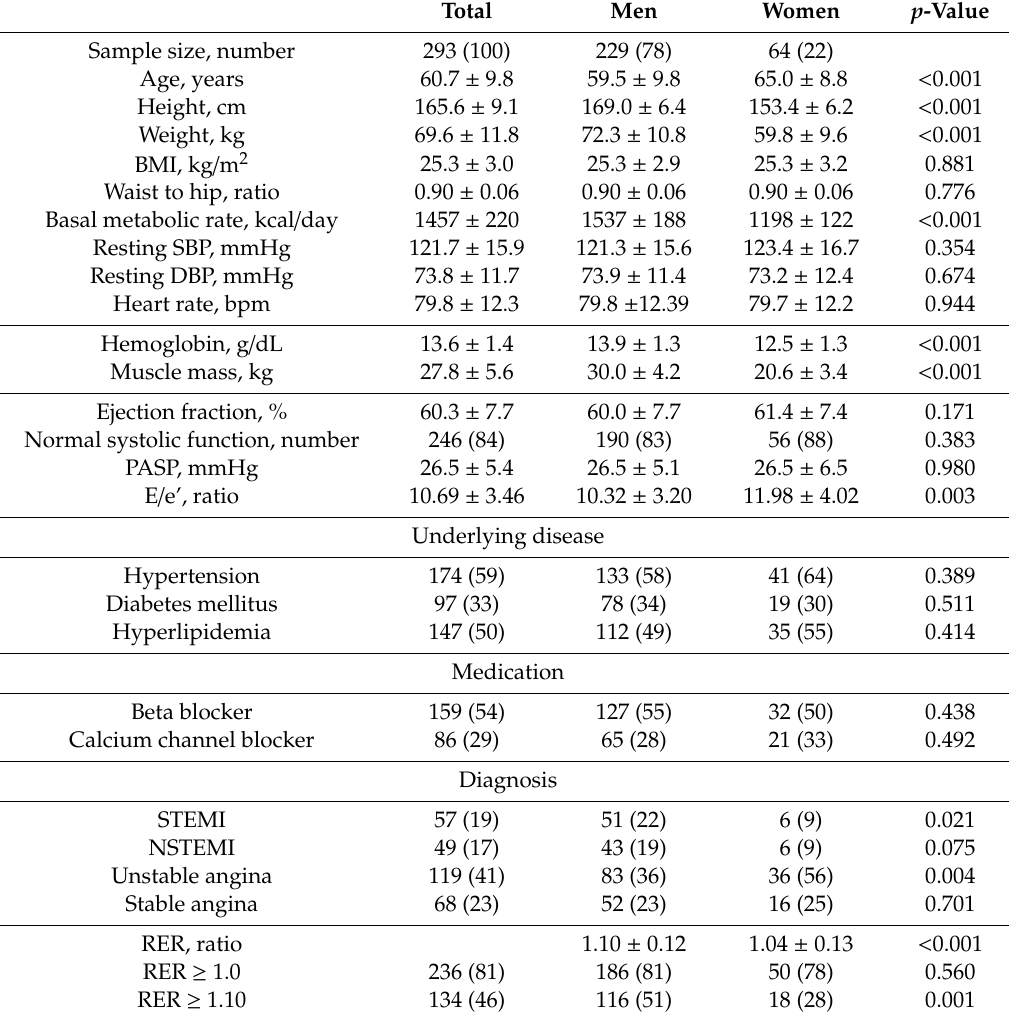
Table 2. Baseline characteristics of the coronary artery disease